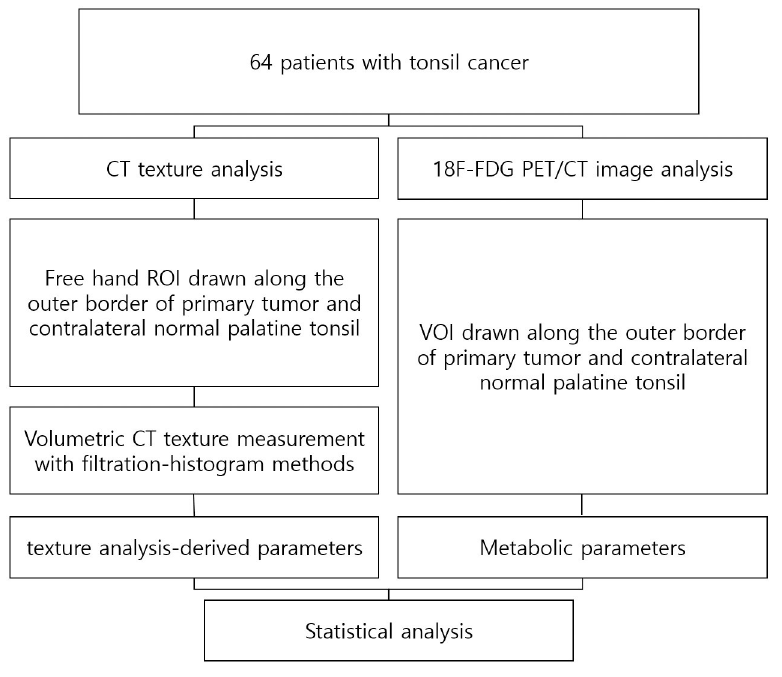
Fig 1. The block diagram of the